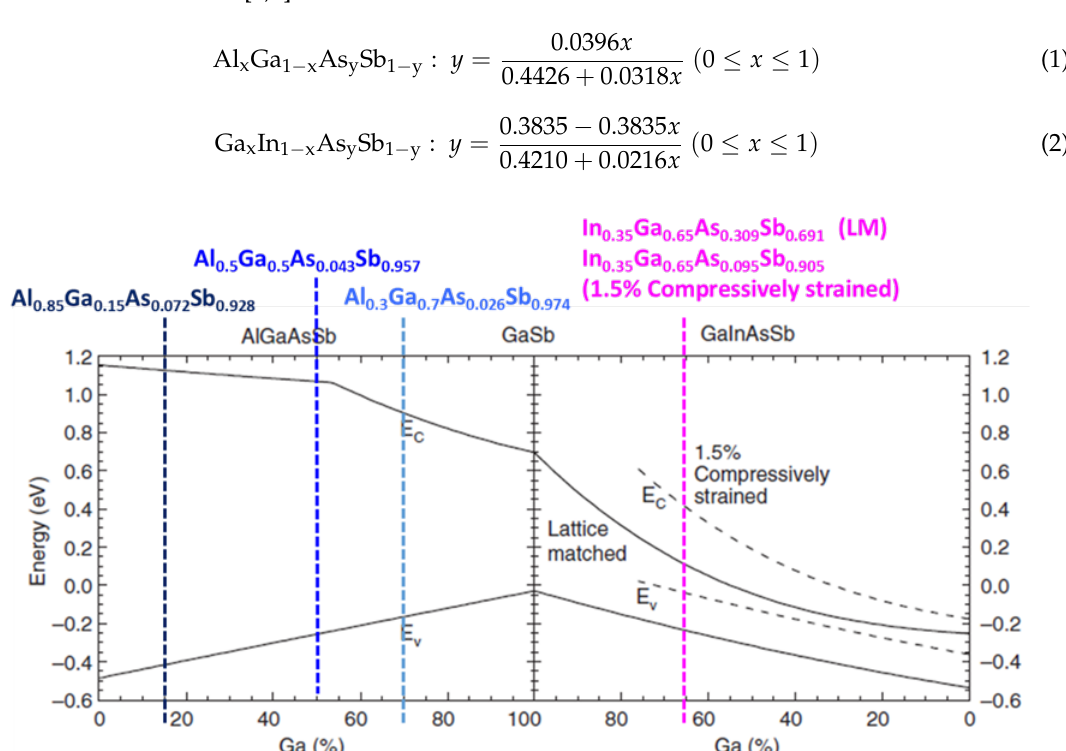
Figure 1. Band-edge positions for AlGaAsSb and InGaAsSb alloys lattice matched to GaSb (solid lines) and 1.5% InGaAsSb alloy under compressive strain (dashed lines). This figure was revised from [5]. The colored dashed lines indicate the target quaternary materials used in this paper.